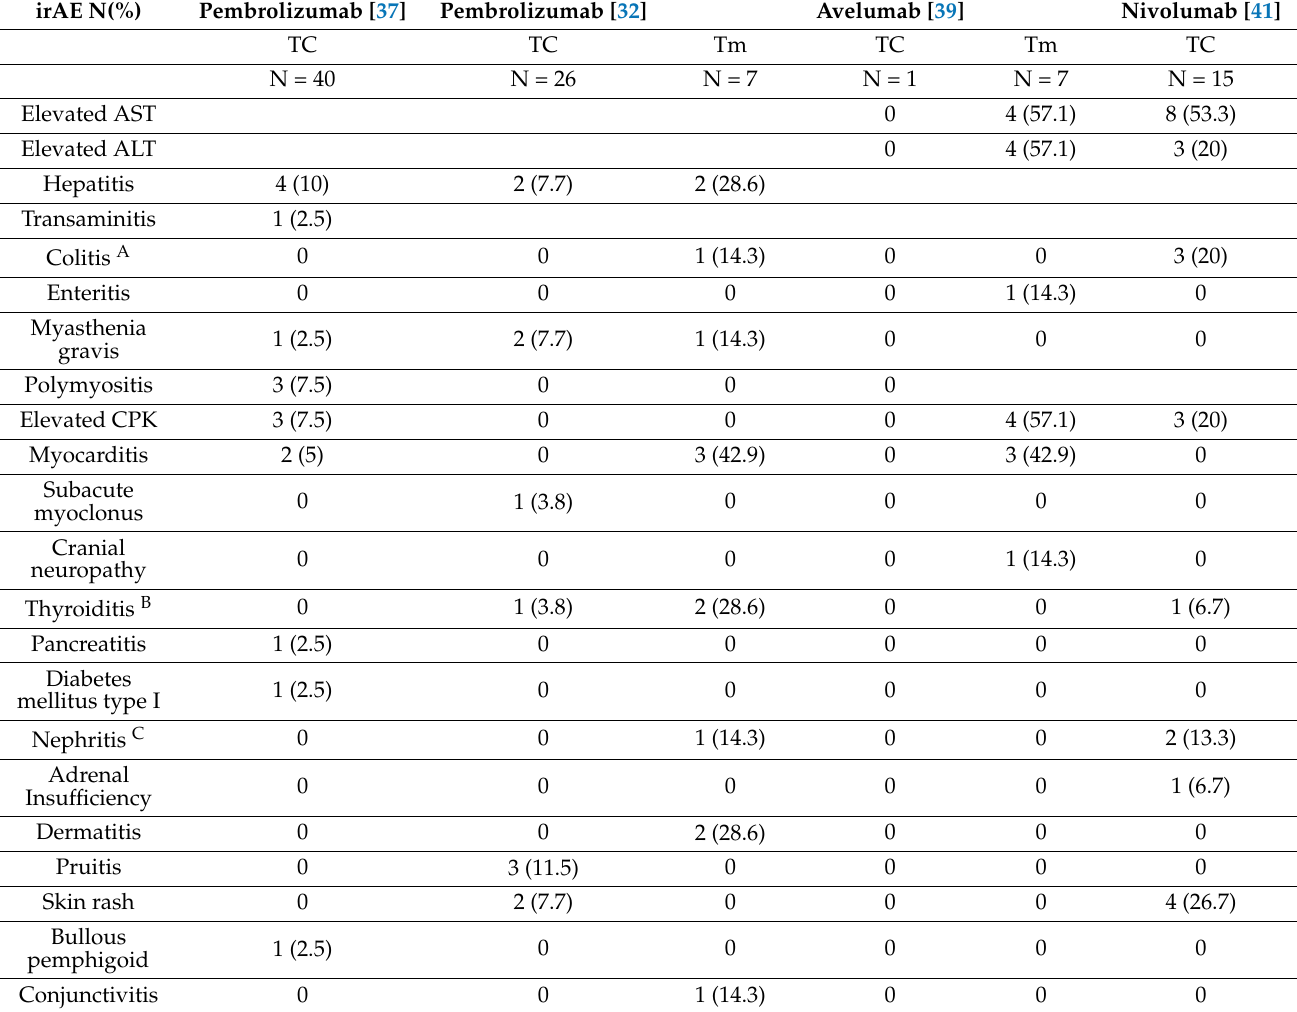
Table 2. Immune-related adverse events that were experienced by patients with thymic epithelial tumors following immune checkpoint